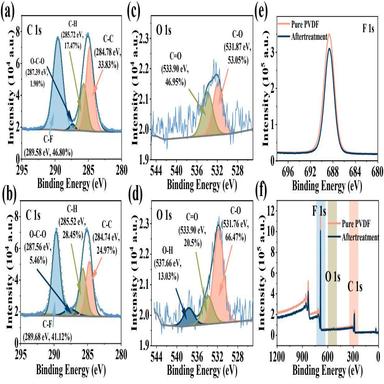
XPS spectra for (a). C 1s of pure PVDF, (b). C 1s of pure PVDF after treatment, (c). O 1s of pure PVDF, (d). O 1s of pure PVDF after treatment, (e). F 1s of pure PVDF and after treatment and (f). Wide range of pure PVDF and after treatment in USFH.